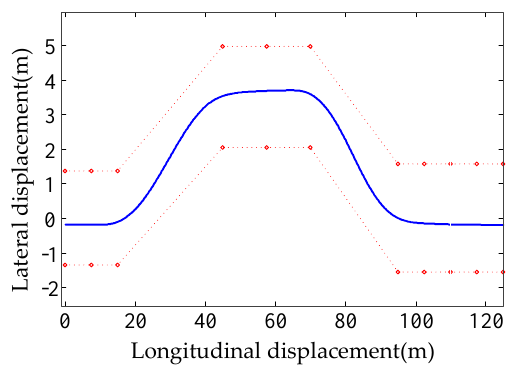
Figure 15. Vehicle driving path.